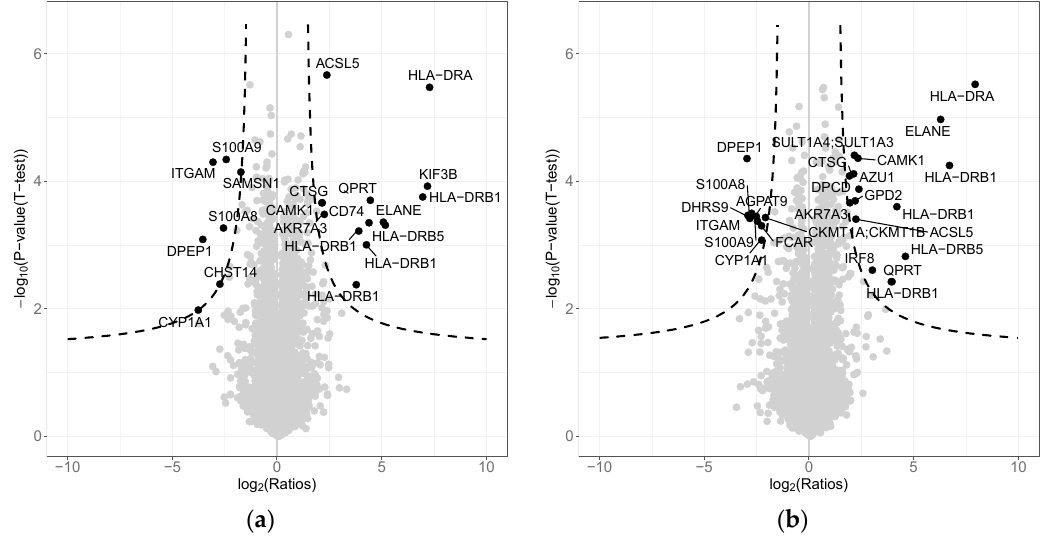
Figure 5. LC ‐ MS/MS (liquid chromatography ‐ tandem mass spectrometry) analysis, volcano plots show the differences of protein abundance comparing the control cells at 24 h + 24 vs. 1 h + 24 ( a ), and lysozyme ‐ treated cells at 24 h + 24 vs. 1 h + 24 ( b ). Dashed lines mark the threshold of statistical significance with FDR < 0.05.